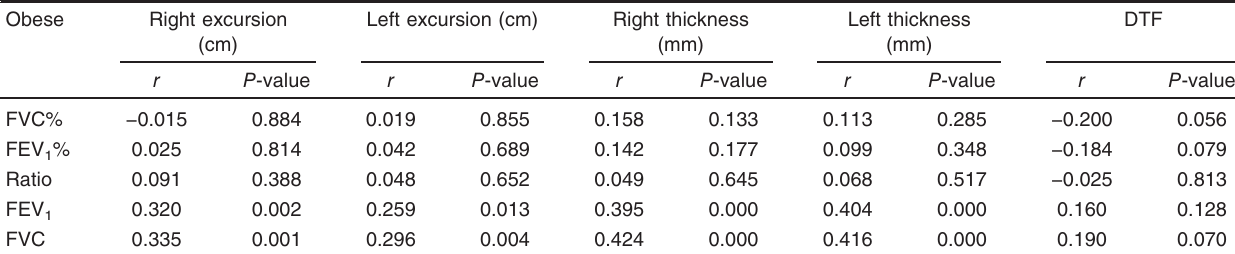
Table 11 Relation between spirometric parameters and ultrasound diaphragmatic parameters in obese persons Obese Right excursion Left excursion (cm) Right thickness (cm)